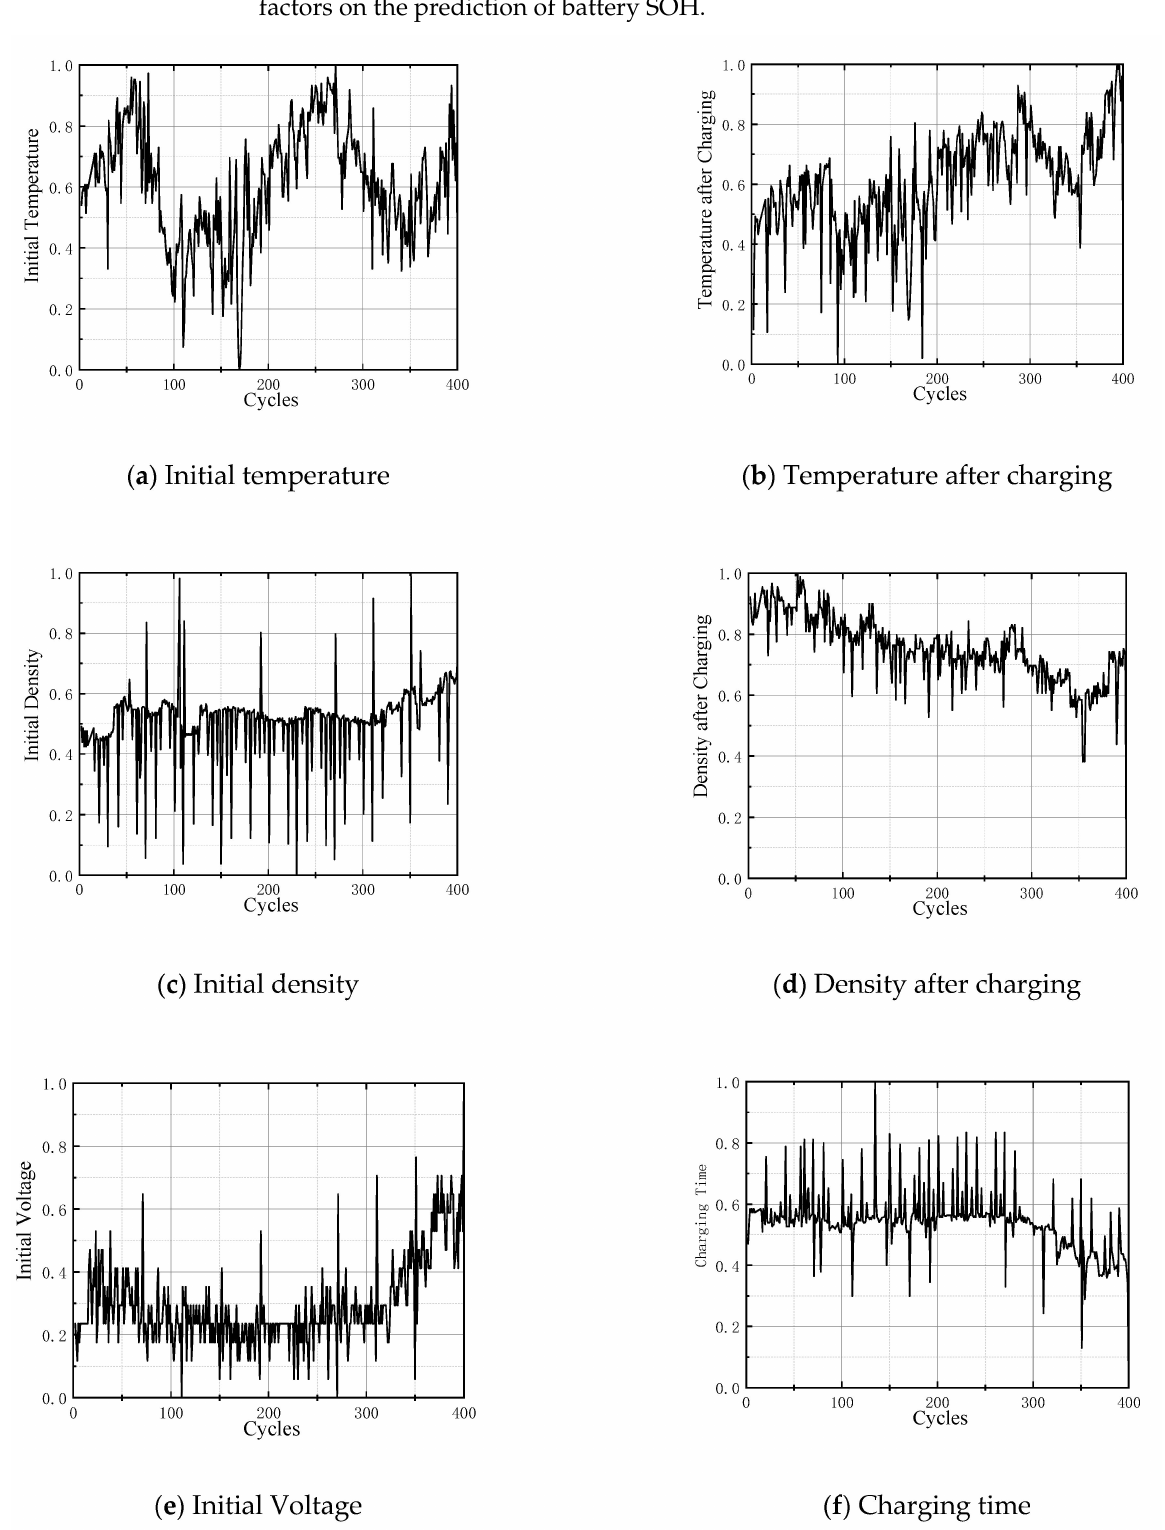
Figure 7. Change trends of different